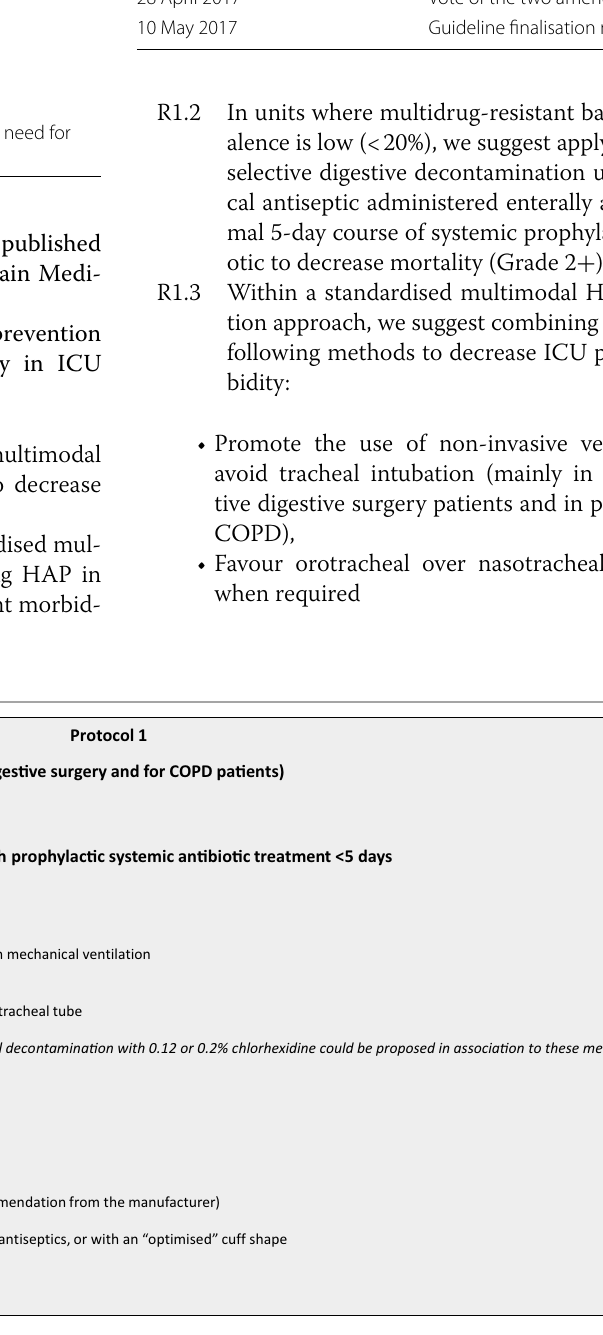
Fig. 1 Multimodal healthcare associated pneumonia prevention protocol (expert